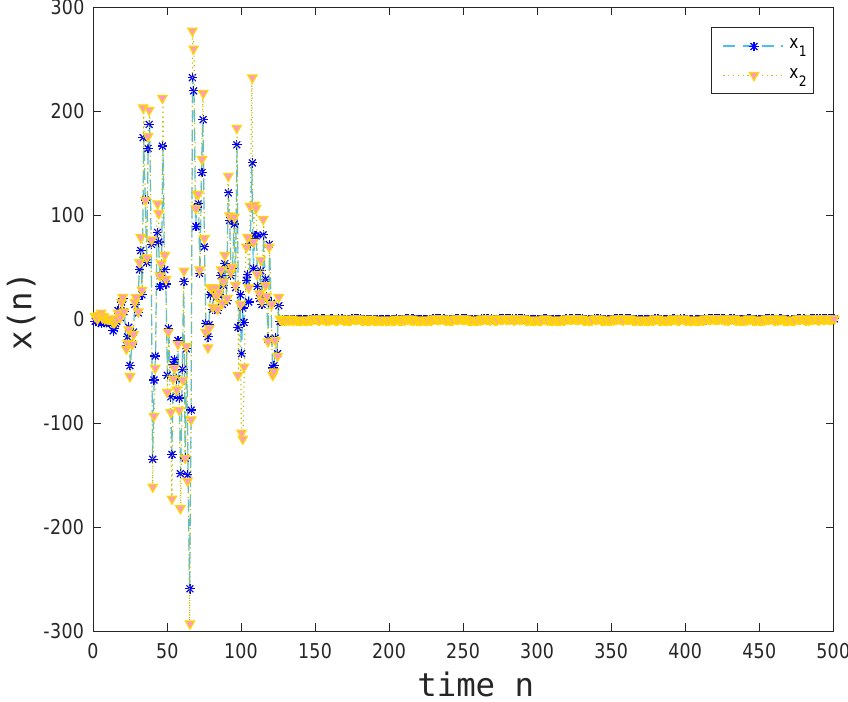
Figure 1. State trajectories of system (37) under destabilizing impulsive